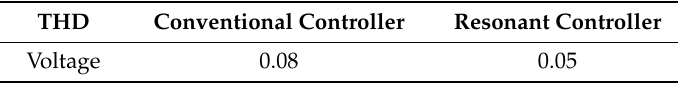
Table 2. THD (Total Harmonic Distortion) of